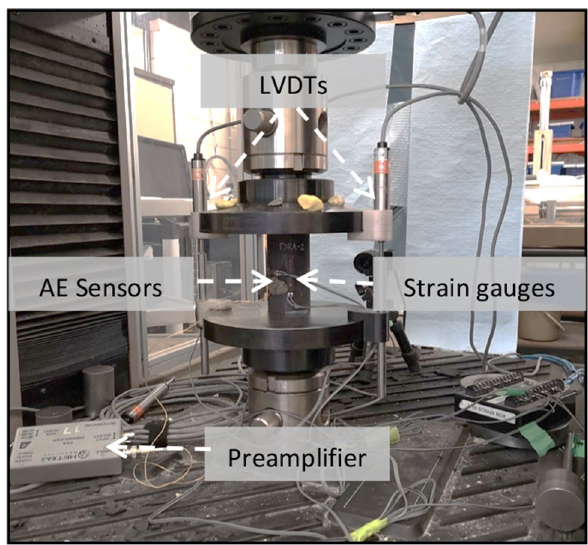
Fig. 7 Experimental setup showing a coal specimen loaded in MTS 300 kN loading frame instrumented with AE sensor and strain